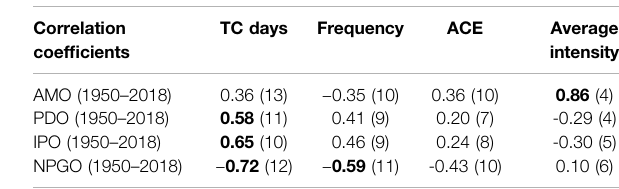
TABLE 1 | Correlations Between Four WNP TC Metrics and AMO, PDO, IPO, and NPGO for 1950 –